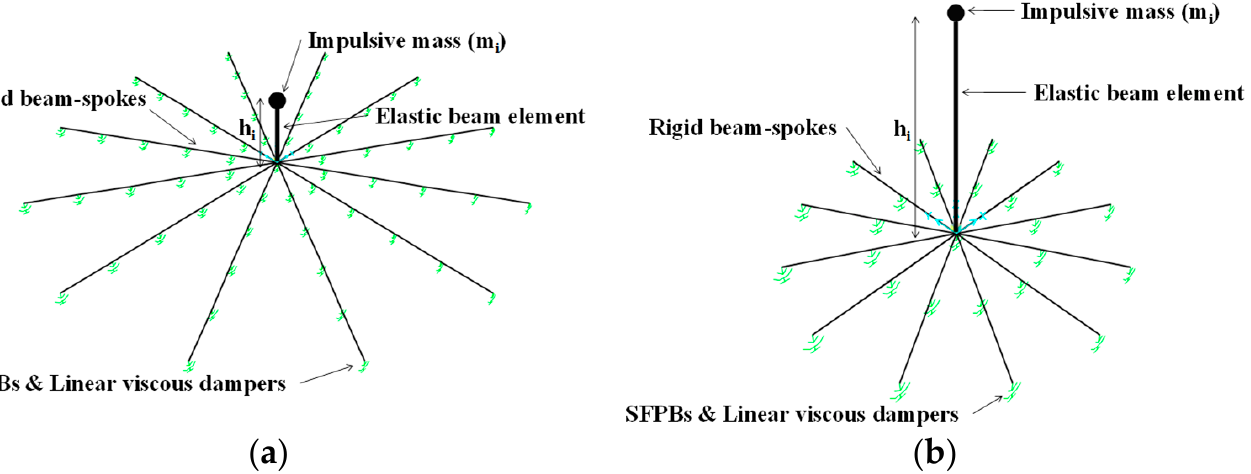
Figure 2. Simplified numerical models of: ( a ) the squat and ( b ) slender tank.